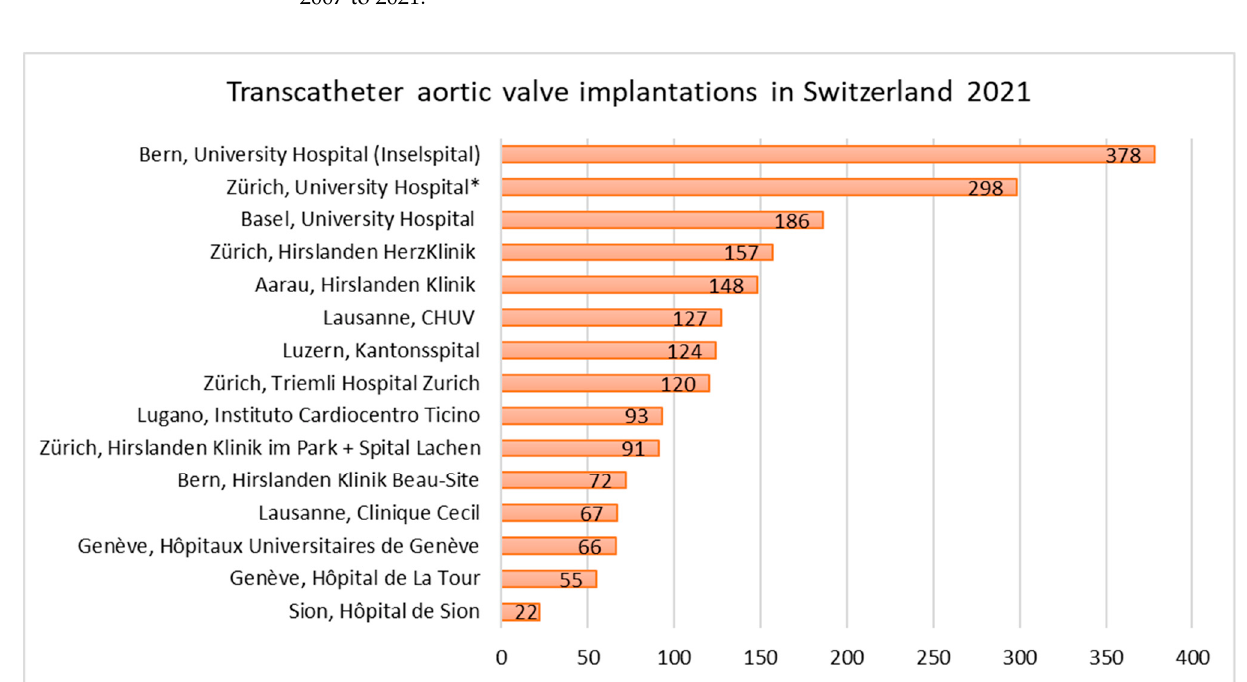
Figure 6. Transcatheter aortic valve implantations in Switzerland, ranked by procedural numbers.